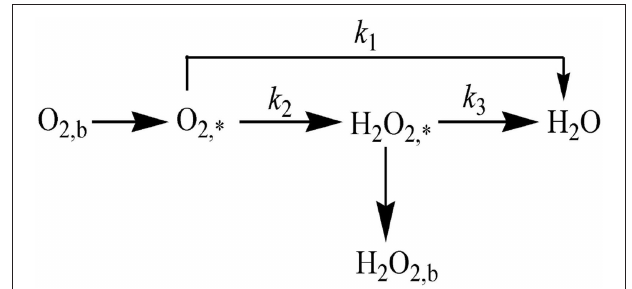
FIGURE 11 | The available routes for ORR. Footnotes b and * refers to the bulk solution substance and electrode surface substance, respectively.